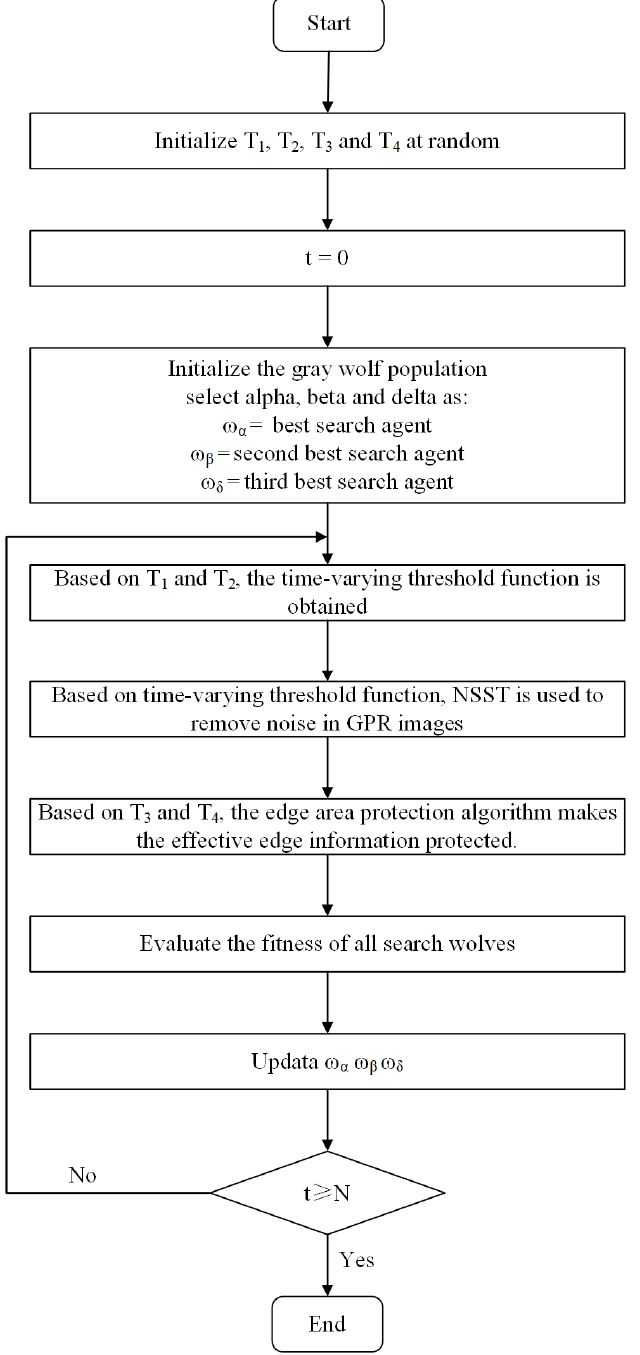
Figure 4. Flowchart of the proposed GPR image denoising process.